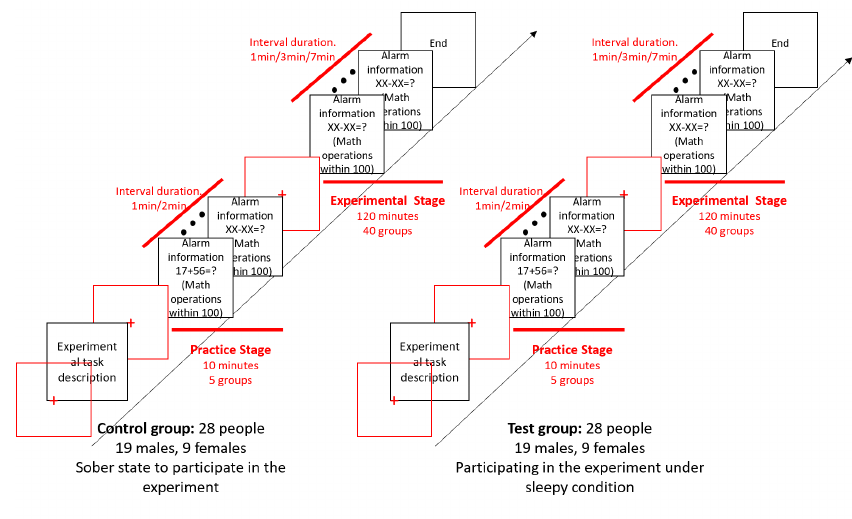
Figure 5. Experimental flow chart.